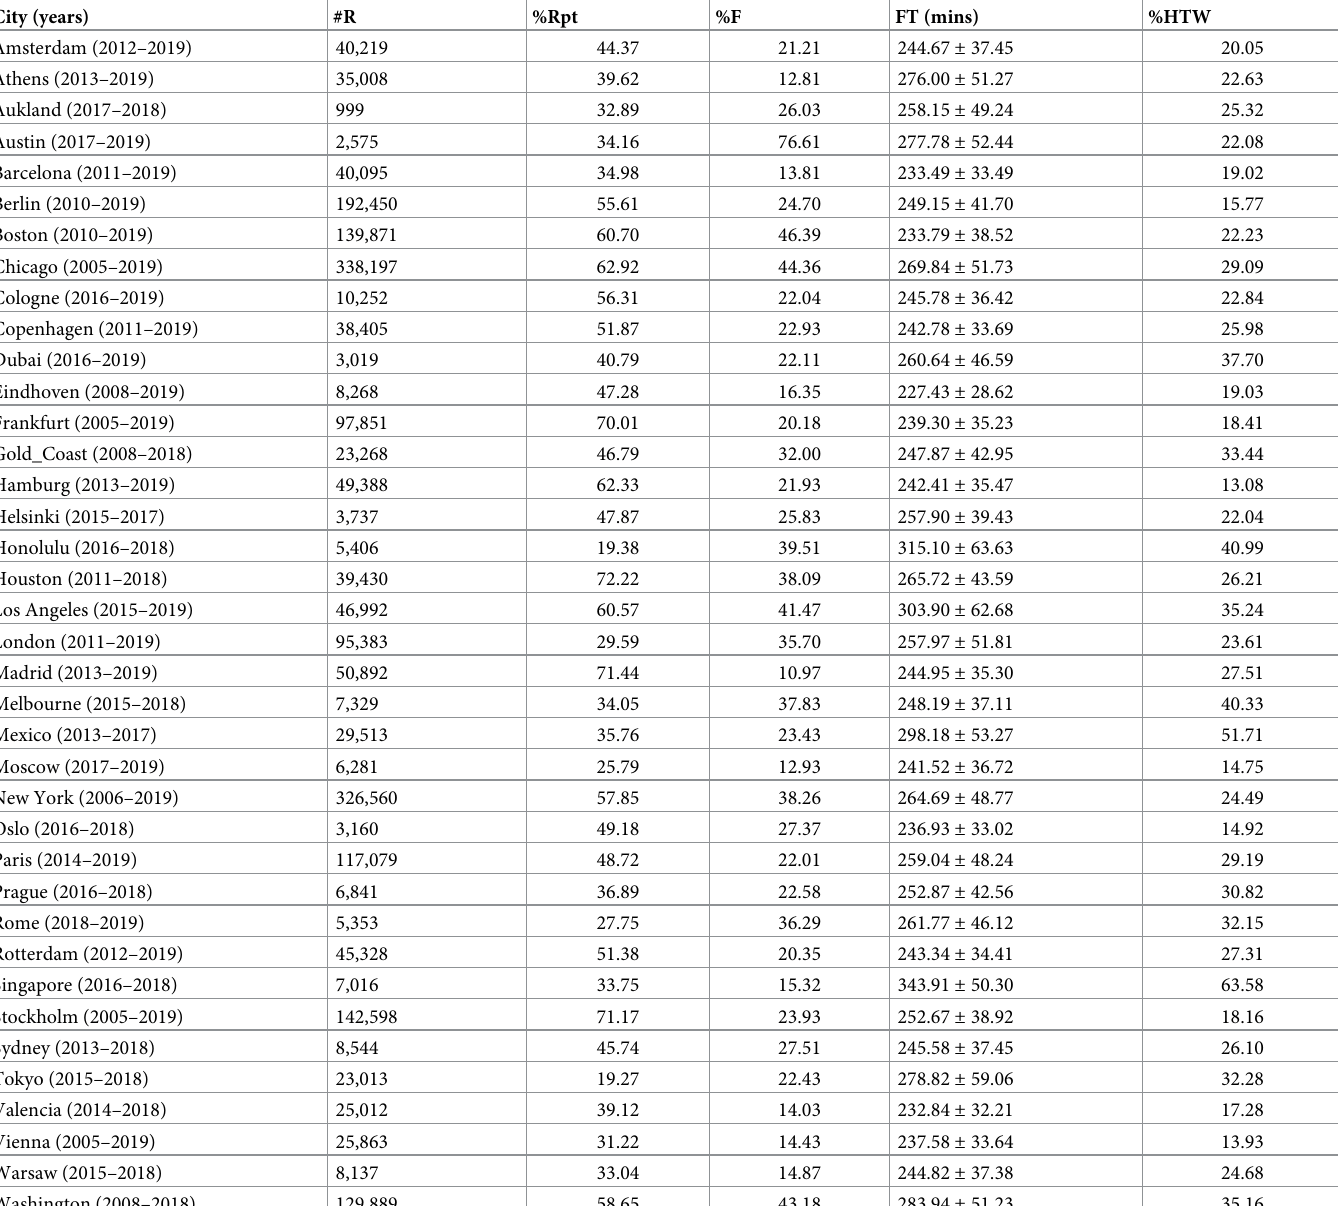
Table 3. A summary of the repeaters dataset by city/race showing the city name and years for which there are data, the number of runners (# R ), the percentage of female runners (% F ), the average finish-time ( FT ) and the percentage of runners hitting the wall (% HTW ) based on the operational defintion adopted here. City (years)